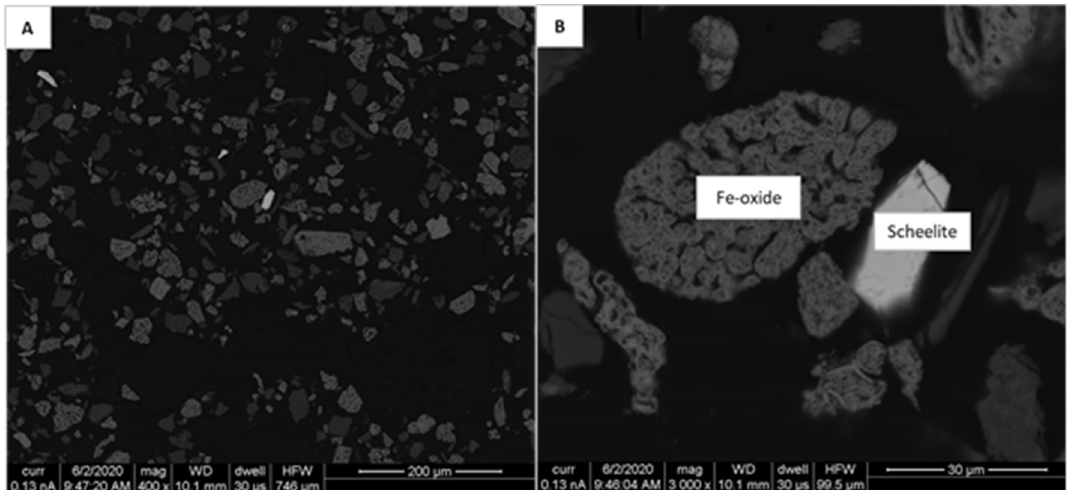
Figure 4. Back scattered electron images showing the overall texture of the sample ( A ) as well as the observed altered iron-oxide grains ( B ). Brightest grains are of scheelite (CaWO 4 ).